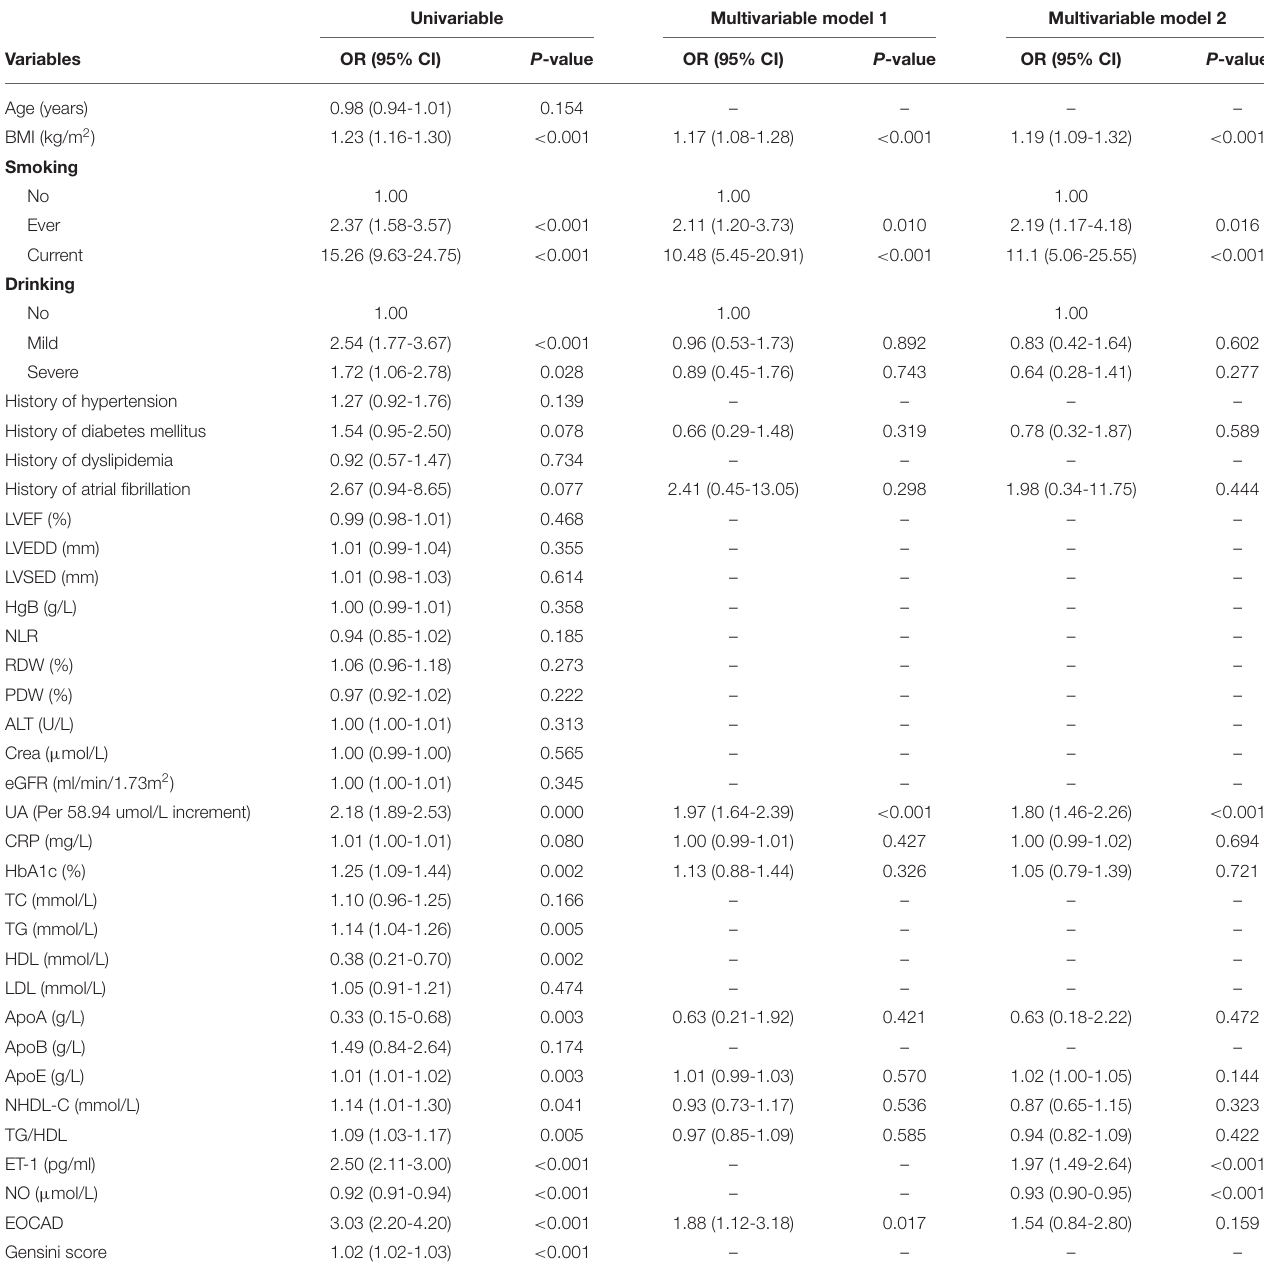
TABLE 3 | Associations between ED and risk factors by univariable analysis and multivariable logistic